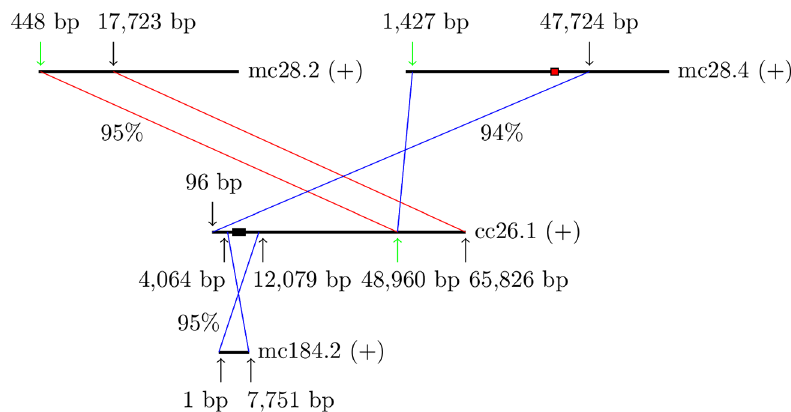
Fig 3. Chromosomal rearrangement between Fv Mont-1 and Fv Clinton-1B. Each horizontal line represents a contig with its name and orientation (+ denotes forward) given on the right. A unique significant match between contig regions in opposite orientations is indicated by a pair of cross lines; one in the same orientation by a pair of parallel lines. In each case, the percent identity of the match is shown next to the lines. The beginning and end of each contig region in the match are marked with vertical arrows along with their positions in bp. A red box in contig mc28.4 and a black box in contig cc26.1 represent different islands surrounded by the match; the black box is part of the match with contig